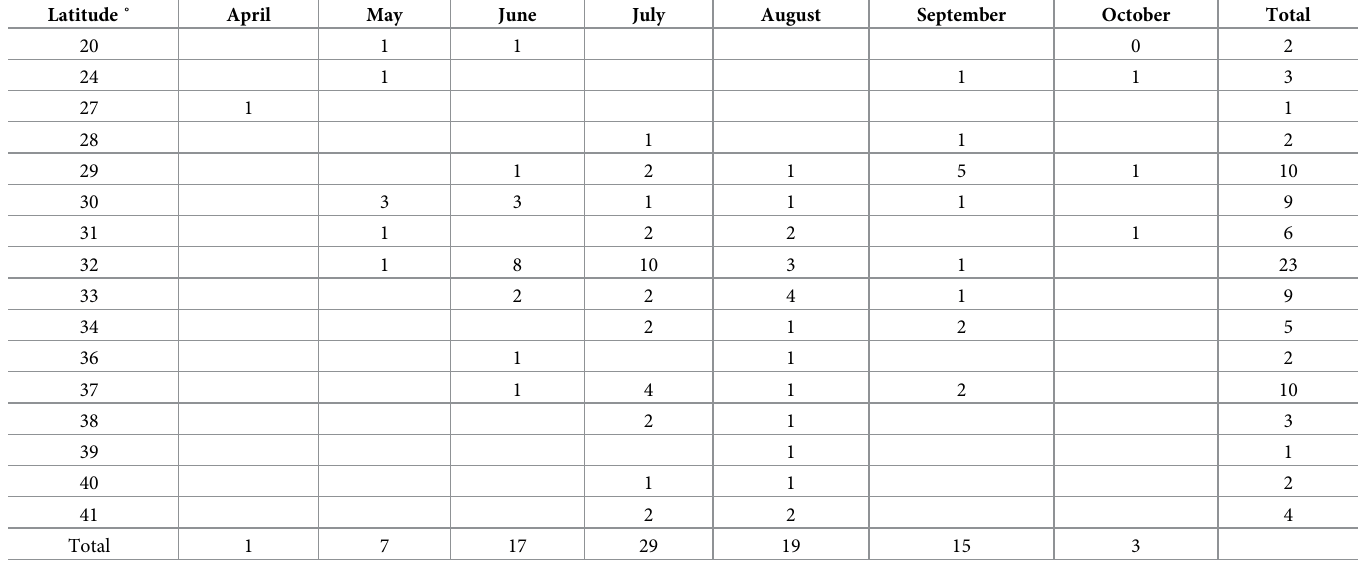
Table 2. Seasonal P . (Par . ) sergenti density according to the latitude. The month with the highest relative density in the 63 locations was reported as a function of the latitude. Latitude ˚